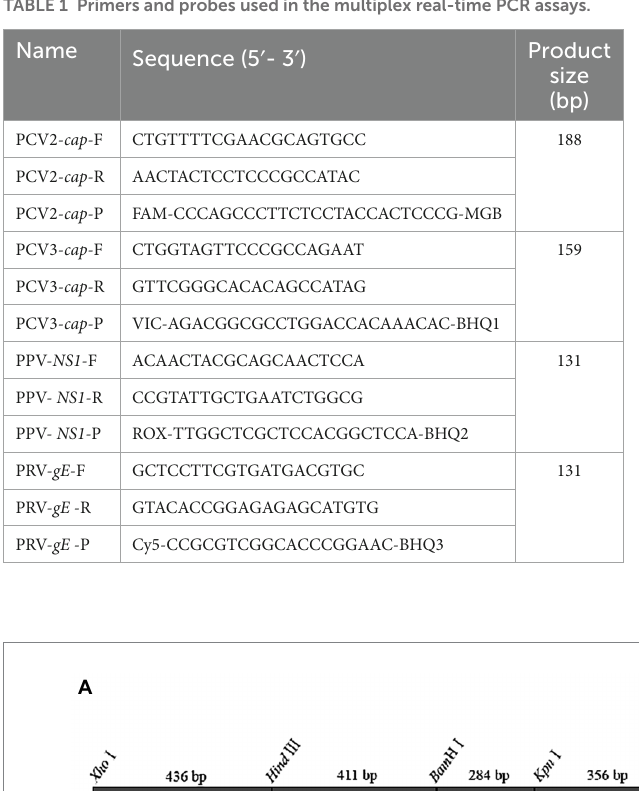
TABLE 1 Primers and probes used in the multiplex real-time PCR assays.